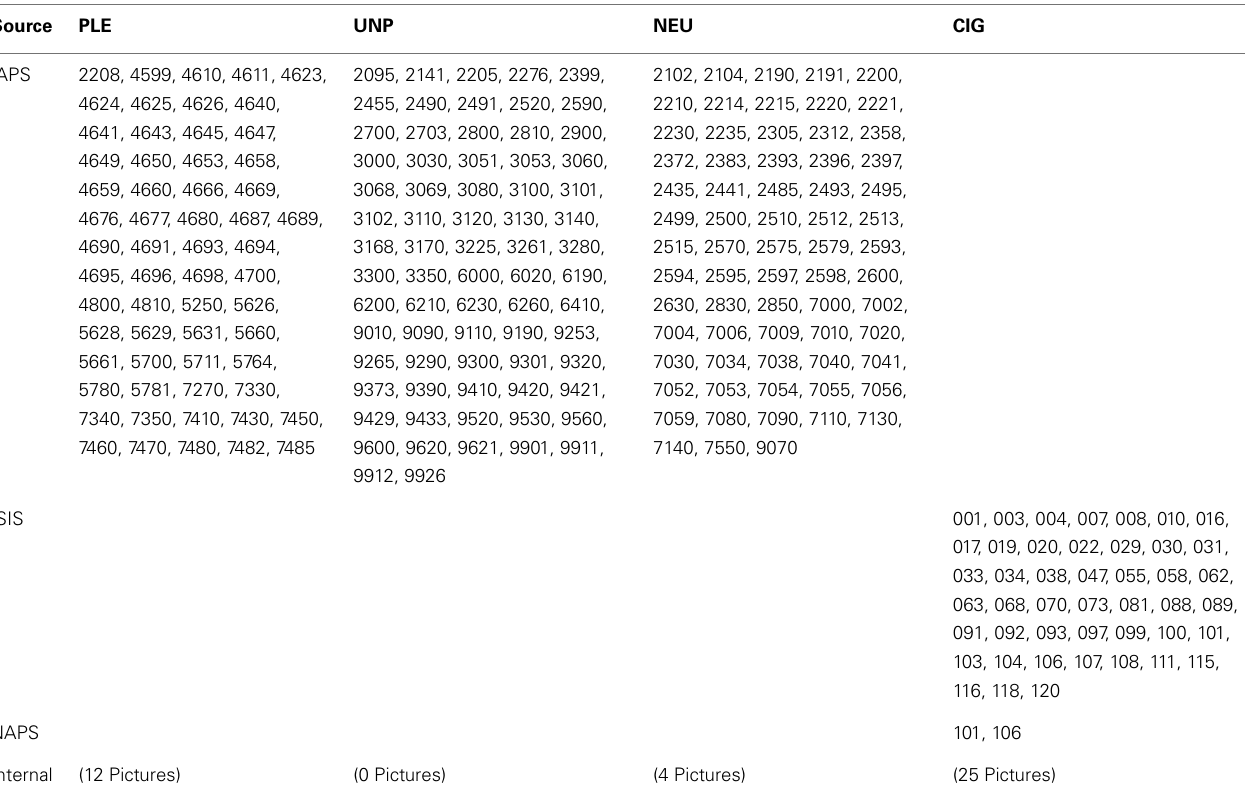
Table 1 | List of pictures used in the picture-viewing task, by picture category and